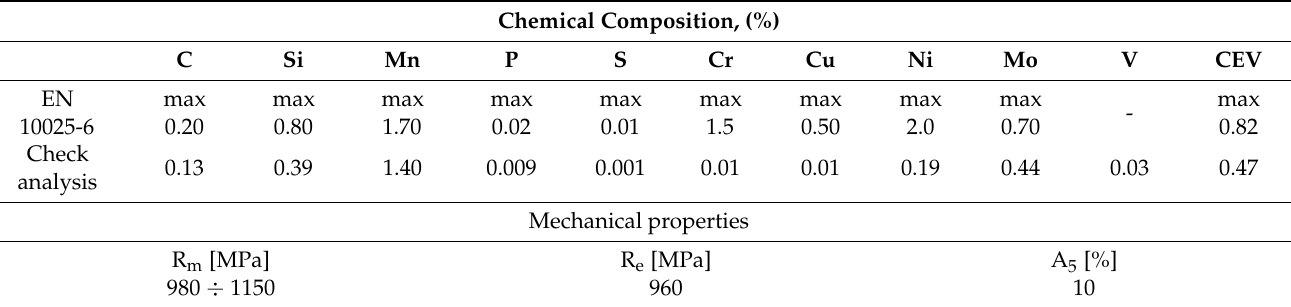
Table 1. Chemical composition and mechanical properties of the test plates made of steel S960QL.